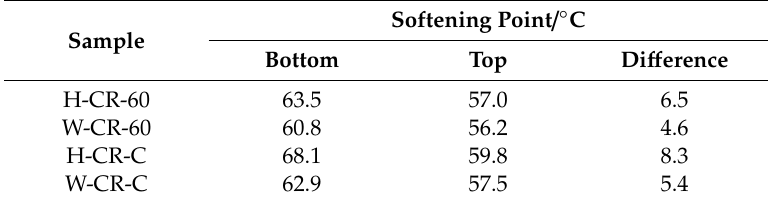
Figure 1. Crumb rubber-modified asphalt mixtures gradation. Table 2. The softening points of the top and bottom of the samples after storing at 163 ℃ for 48 h.